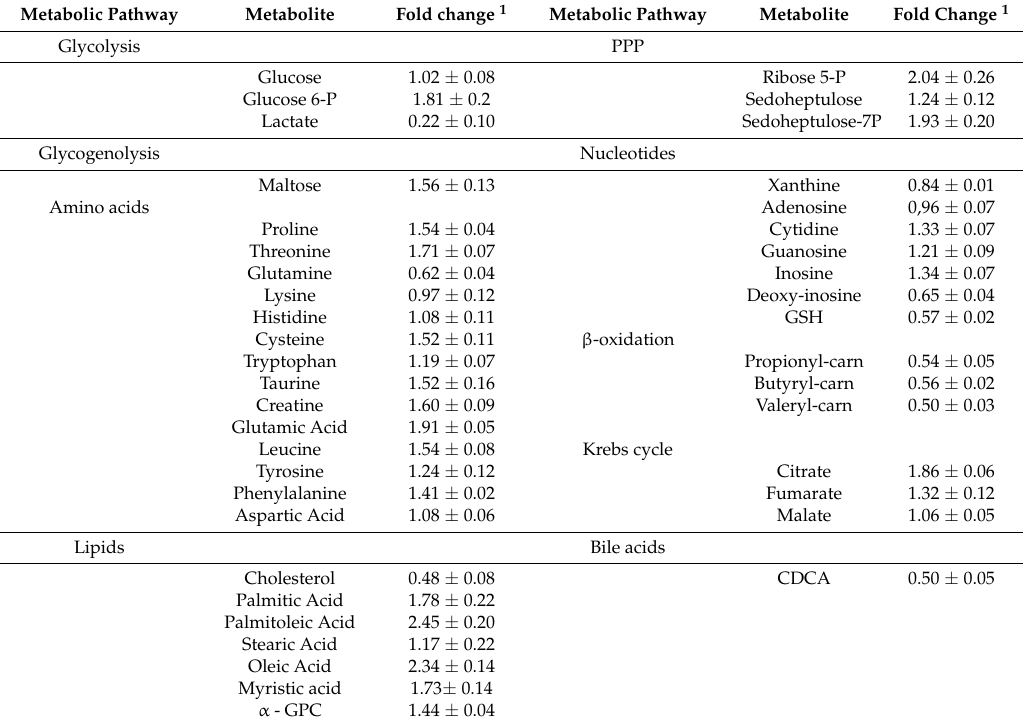
Table 1. Fold induction for the indicated metabolites measured upon treatment of HuH7 with AAE. Metabolic Pathway